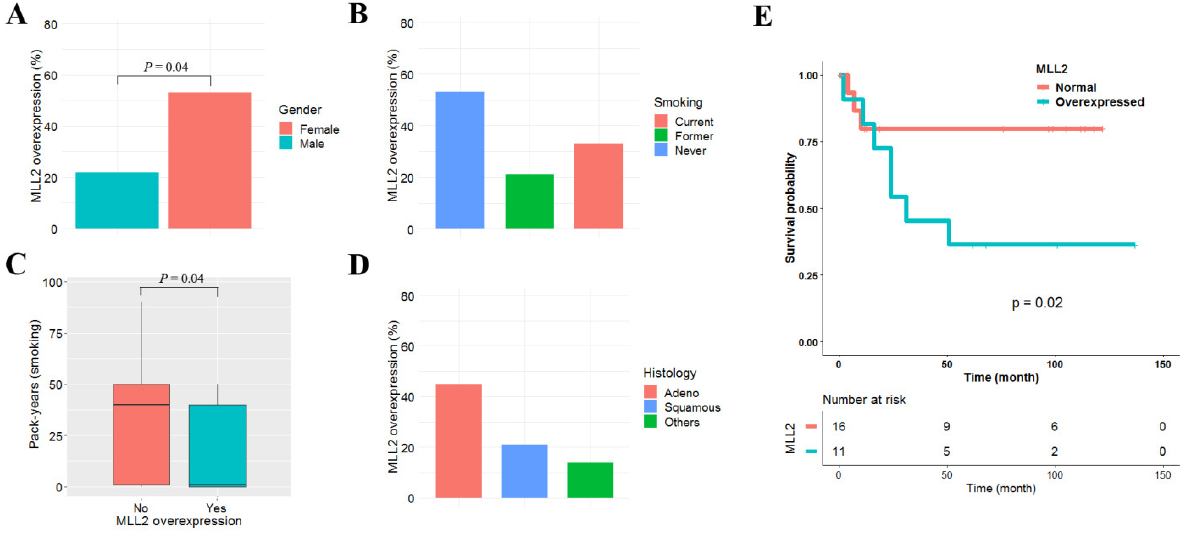
Figure 6. Effect of MLL2 overexpression on recurrence-free survival in lung adenocarcinoma. Clinicopathological signifi- cance of MLL2 overexpression in 42 primary NSCLCs. MLL2 overexpression was compared according to sex ( A ), smoking status ( B ), pack-years ( C ), and histology ( D ). The effect of MLL2 overexpression on the recurrence-free survival of 27 patients with adenocarcinoma was analyzed using Kaplan–Meier survival curves ( E ). The p -value was calculated using log-rank test.